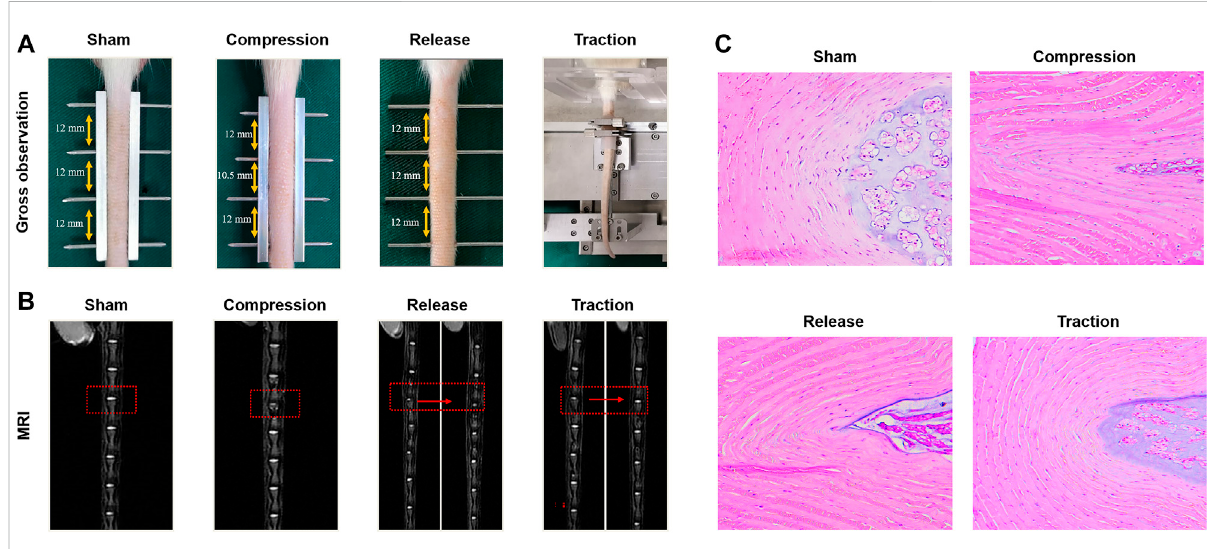
FIGURE 3 Effects of different modes of mechanical loading on the in fl uence of IVD in vivo . (A) Gross observation of rat tail IVDs in the sham group, compression group, release group and traction group. (B) Magnetic resonance images (MRI) of IVDs from the groups as described above. (C) H&E staining of IVDs from the groups as described above. Reproduced with permission from Zhang et al. (Zhang W. et al., 2021).